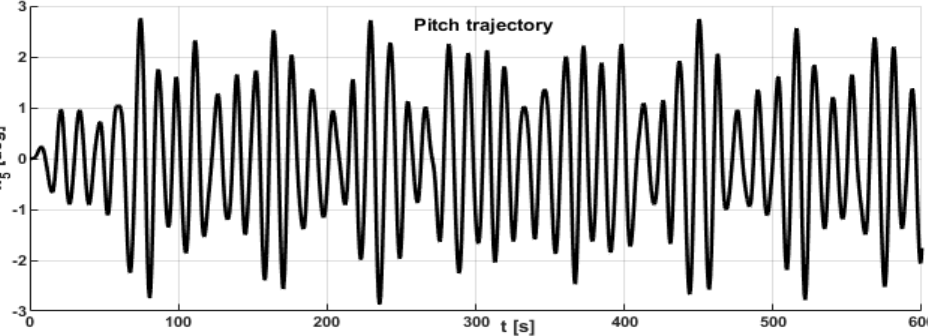
Figure 16. Pitch response to IW8 according to weakly nonlinear time − domain solver.